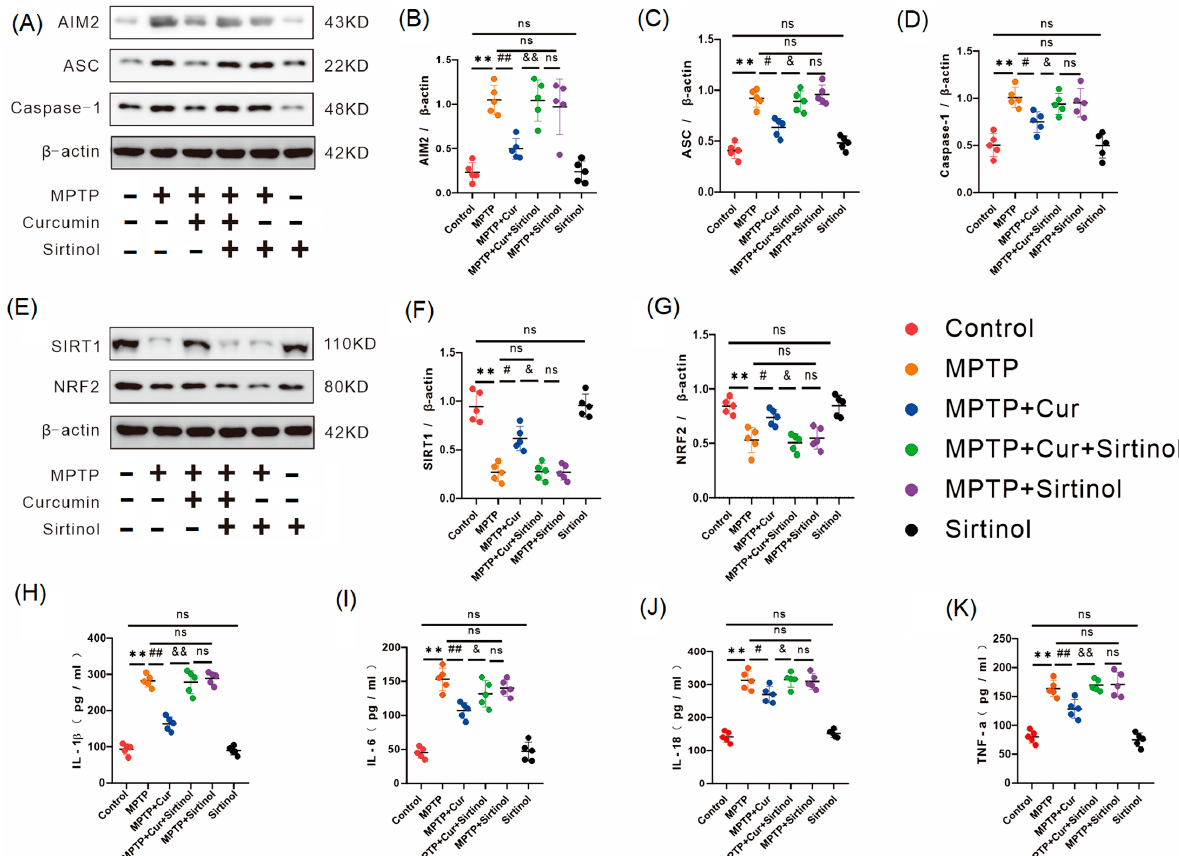
Figure 6. Curcumin inhibited cellular scorching by activating the SIRT1/NRF2 pathway, thereby reducing intestinal inflammation. ( A ) Western blot was used to detect AIM2, ASC, and caspase − 1 proteins in the six groups of cecum tissue ( n = 5); ( B – D ) analysis of AIM2, ASC, and caspase − 1 protein expression in cecum tissue ( n = 5); ( E ) detection of SIRT1 and NRF2 proteins in the six groups of cecum tissue using Western blot ( n = 5); ( F , G ) analysis of SIRT1 and NRF2 protein expression in the six groups of cecum tissue ( n = 5); AIM2, ASC, caspase − 1, SIRT1, and NRF2 protein expressions were quantified using ImageJ; ( H – K ) the expression levels of pro-inflammatory factors IL-1 β , IL-6, IL-18, and TNF- α in intestinal tissue homogenates were analyzed using ELISA ( n = 5). All statistical differences were tested using the t -test ( B – D , F – K ). Data are expressed as the mean ± SEM ( n = 5/group), with representative results for one of the independent experiments. ** p < 0.01 vs. control group. # p < 0.05 and ## p < 0.01 vs. MPTP group. & p < 0.05 and && p < 0.01 vs. MPTP + Cur group. ns, not